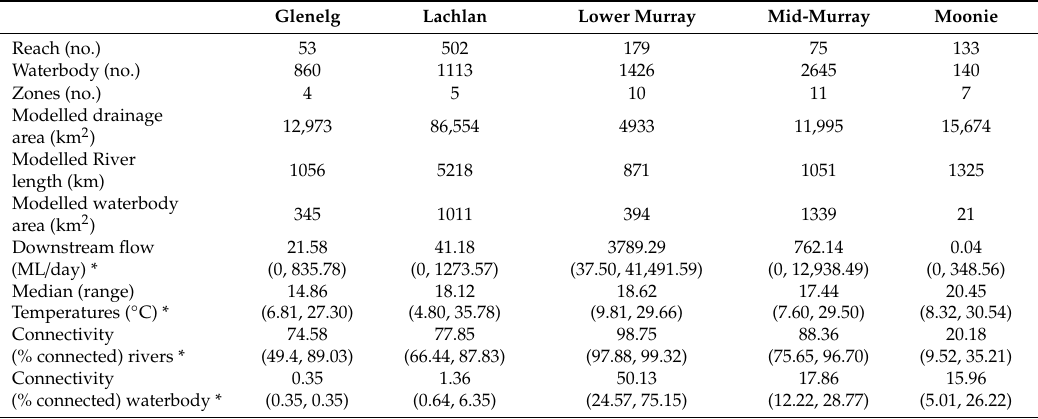
Figure 1. Catchments in southeastern Australia included in the integrated hydrological study. Table 1. Summary of the key hydrological properties of the five studied catchments, data providers, and existing downstream flow modes.